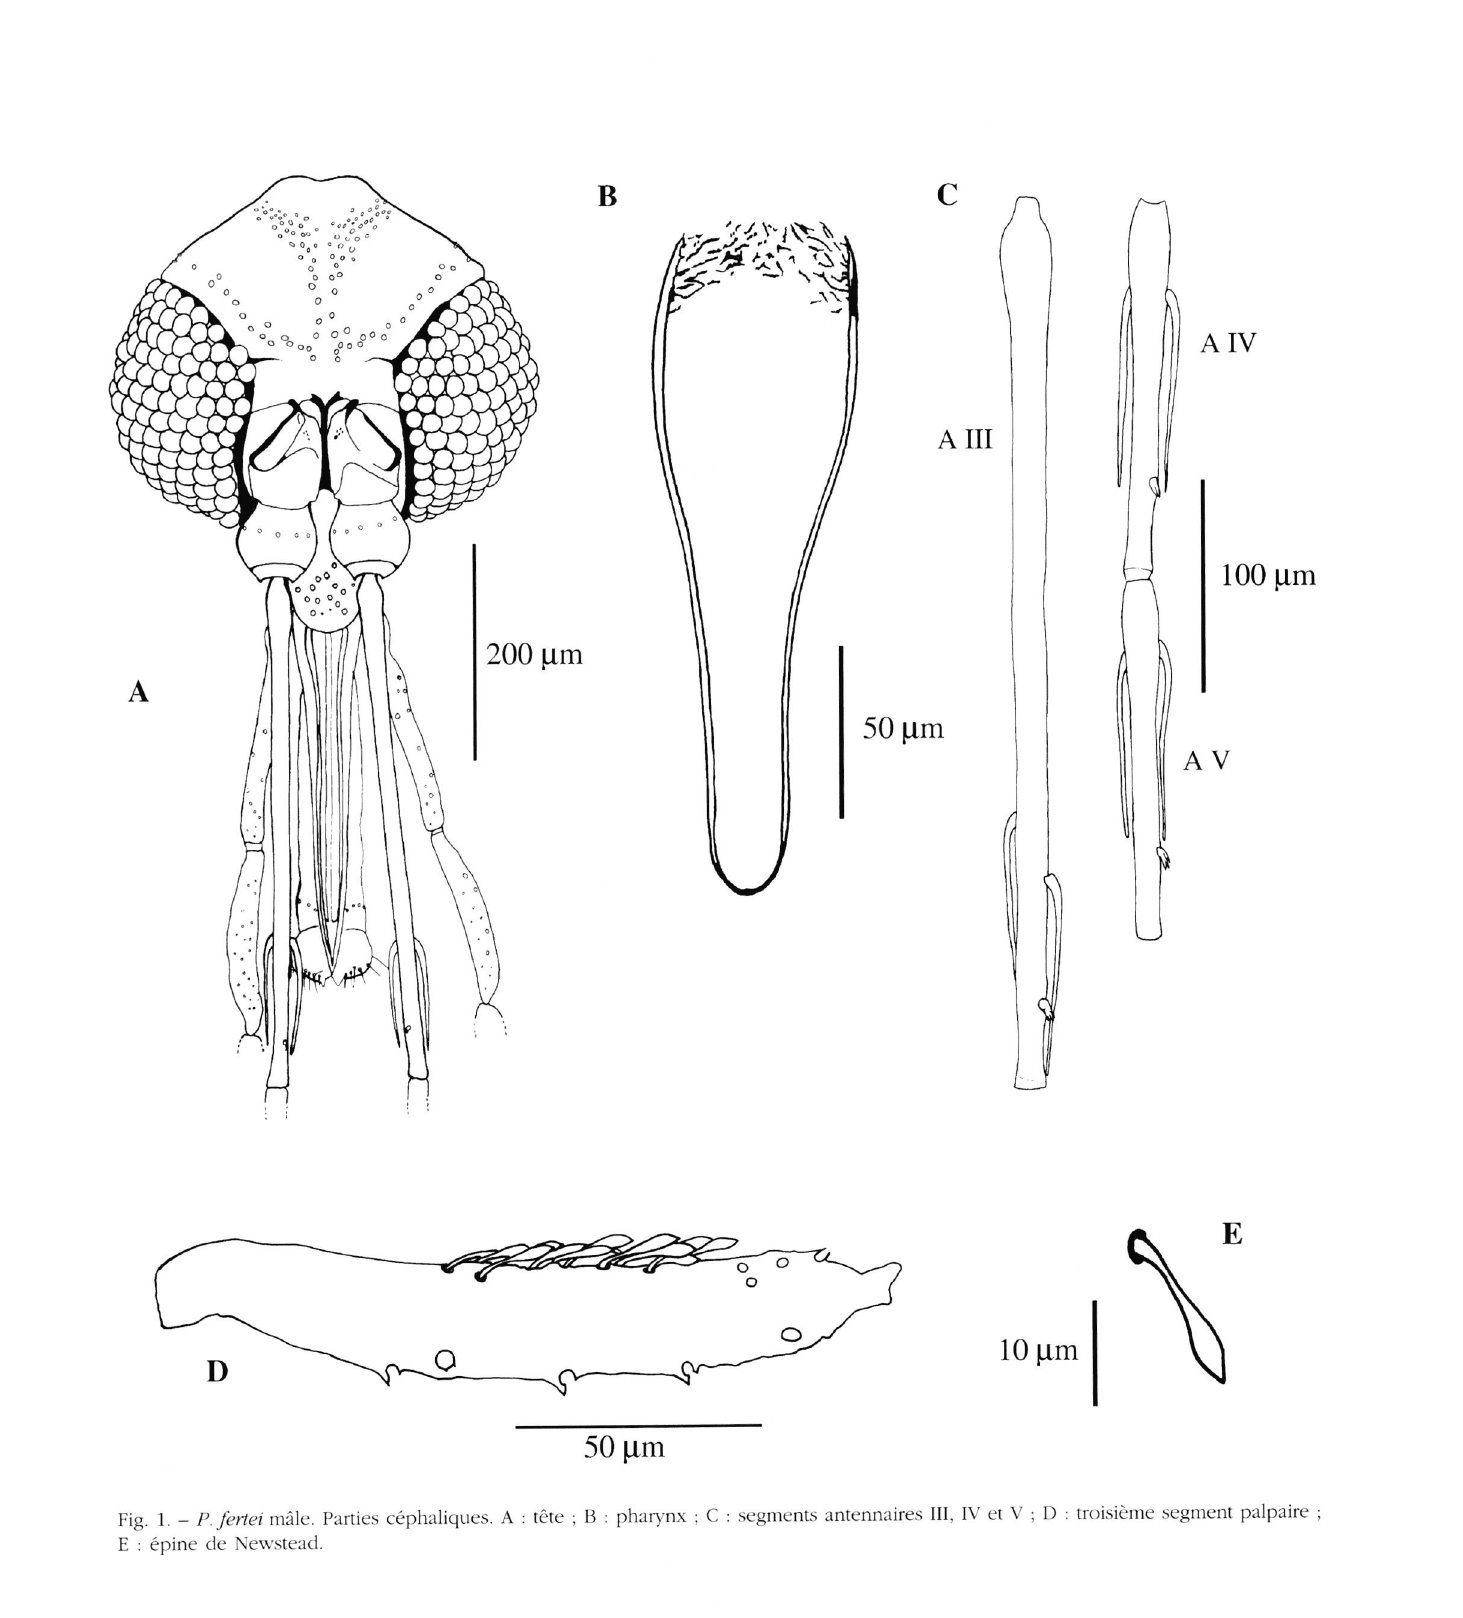
Fig. 1. - P .fertei mâe. Parties céphaliques. A : tête ; B : pharynx ; C : segments antennaires III, IV et V ; D : troisième segment palpaire ; E : épine de